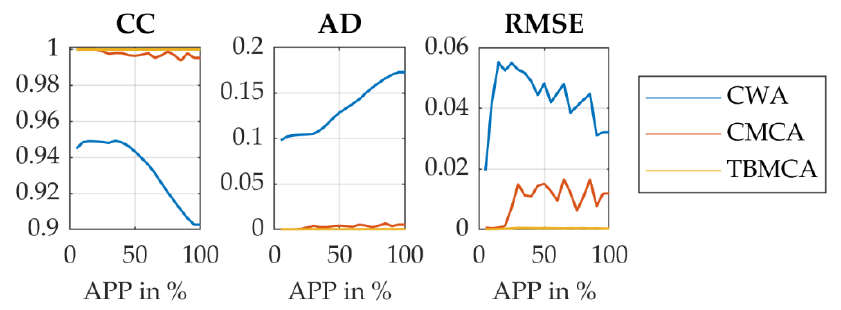
Figure 6. Comparison of the MCAs based on quality metrics.